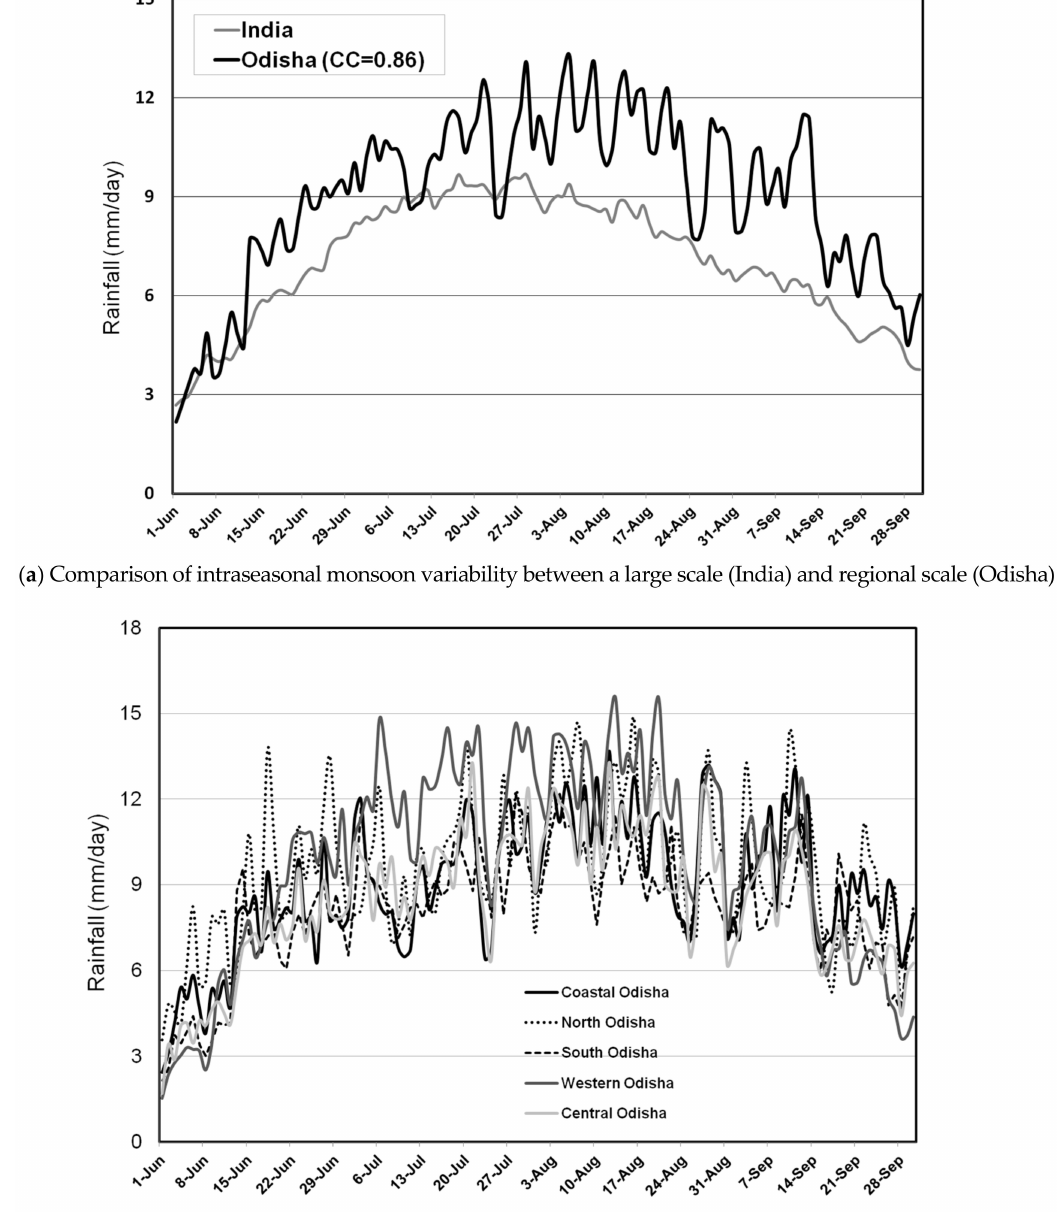
Figure 2. Seasonal cycle of the daily monsoon rainfall climatology averaged over ( a ) all of India and all of Odisha; and ( b ) different zones of Odisha for the period 1 June to 30